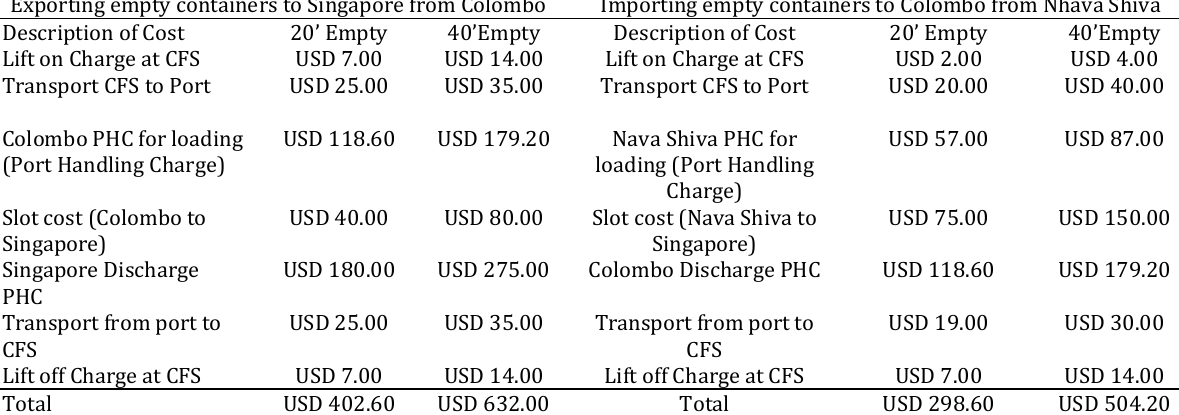
Table 4 : The cost of importing empty containers from Nhava Shiva and exporting to Singapore Exporting empty containers to Singapore from Colombo Importing empty containers to Colombo from Nhava Shiva